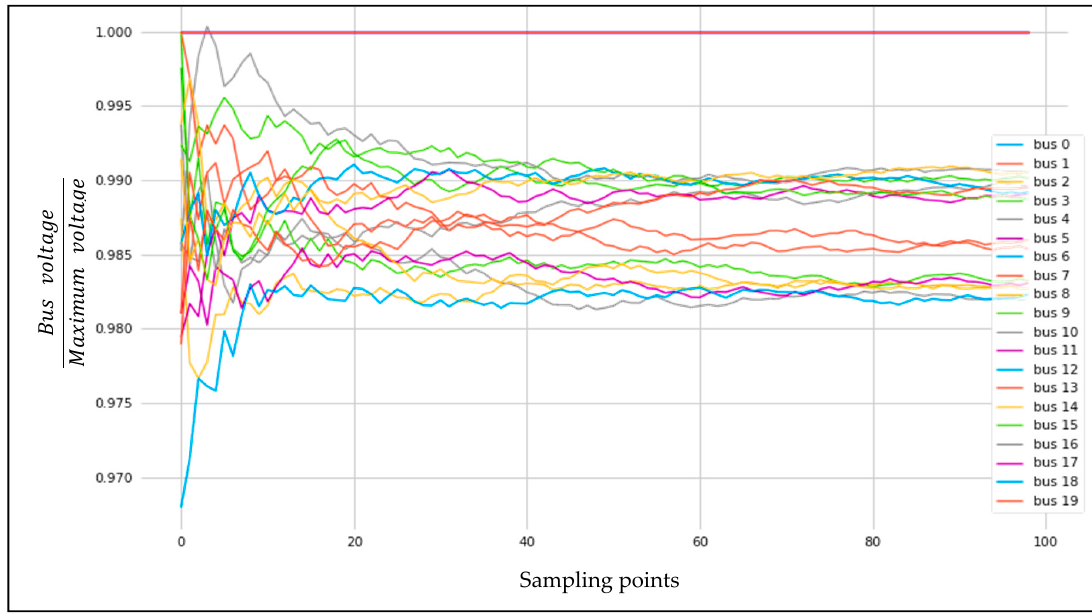
Figure 19. NASA N3-X bus voltage average, calculated by Latin hypercube, in the cruising condition.